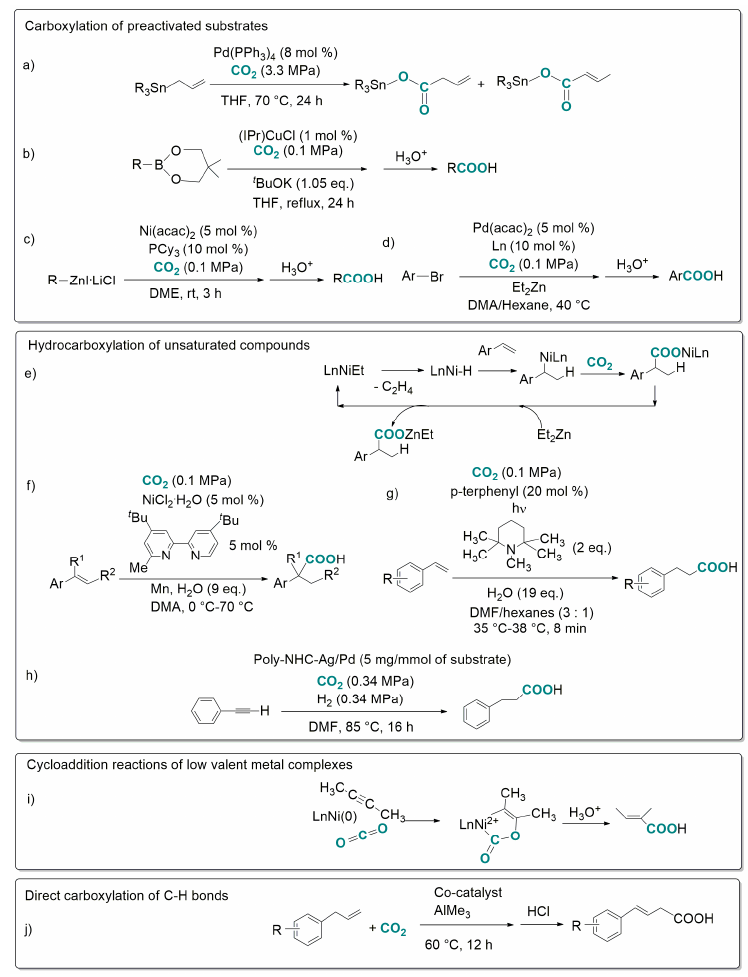
Scheme 1. Examples of transition ‐ metal ‐ catalyzed synthesis of carboxylic acids (and